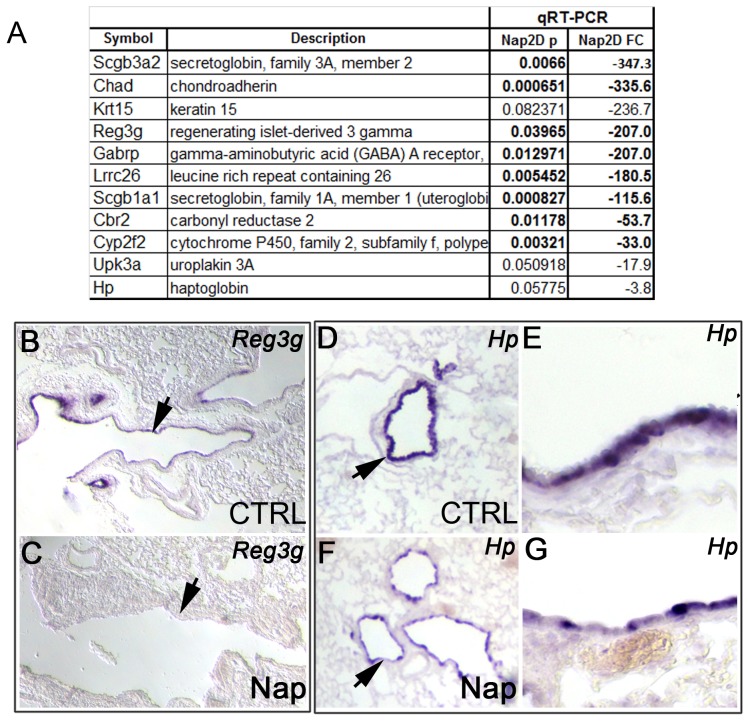
Impact of Naphthalene injury on the expression of genes identified by transcriptional profiling.
(A) qRT-PCR analysis of gene expression in mock-treated (corn oil, CTRL) and Naphthalene-treated (Nap) lungs 2 day post-injection (n = 3 lungs per condition). (B–G) ISH for Reg3g (B–C) and Hp (D–G in CTRL (B, D–E and Nap-treated lungs (F–G respectively. E, G are higher magnification images of airways shown in D, F respectively.